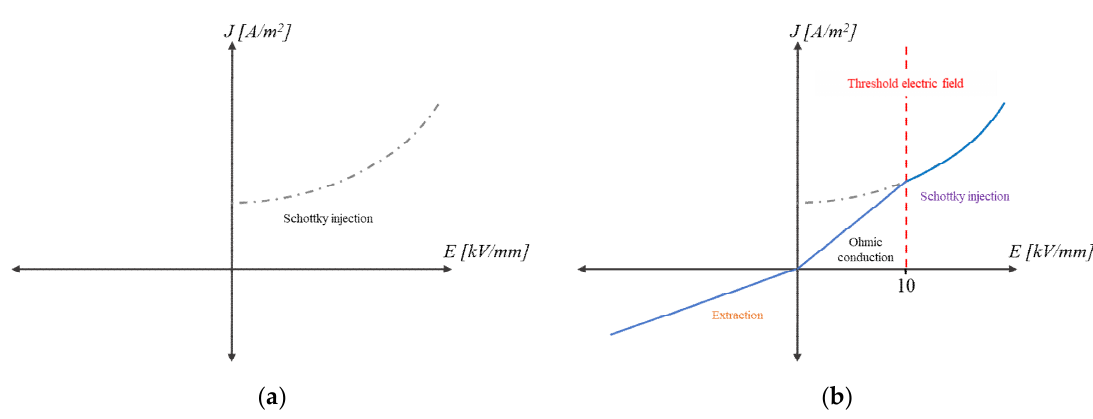
Figure 5. Modification of boundary conditions considering polarity reversal: ( a ) Conventional condition; ( b ) modified condition.